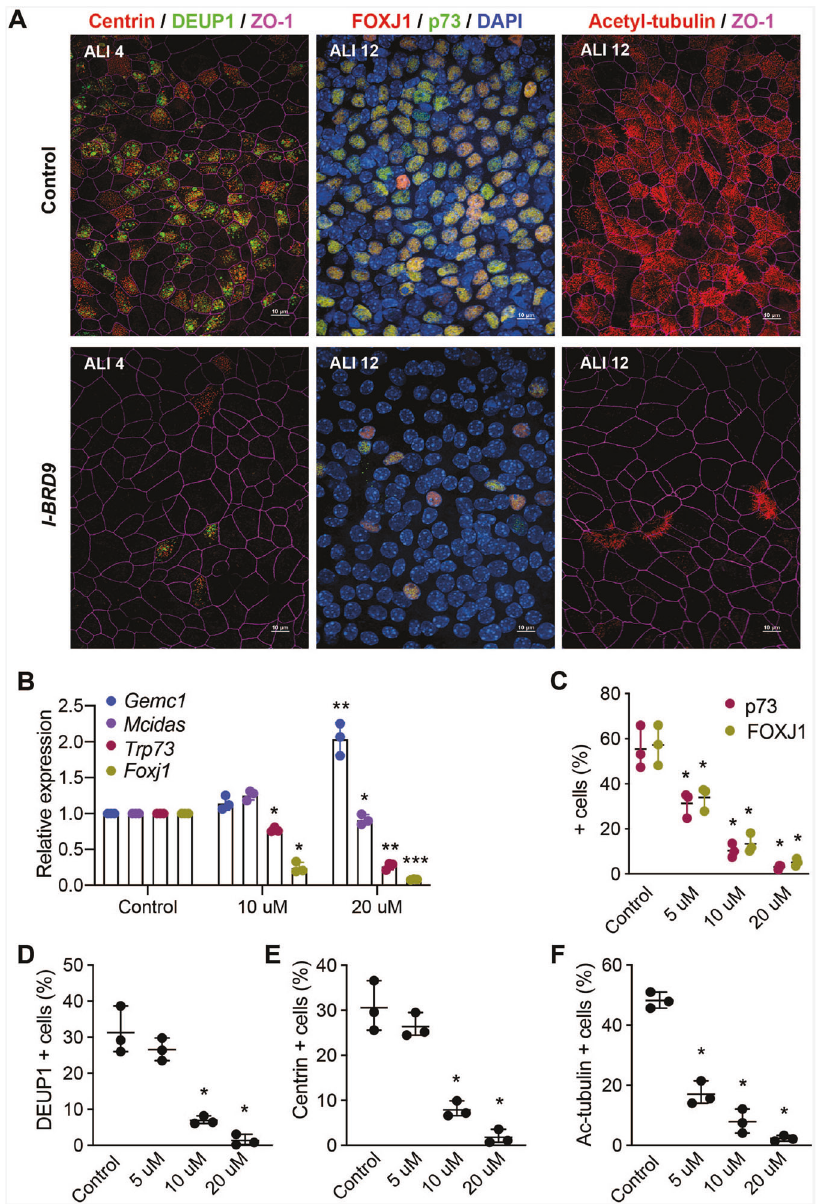
Fig. 6 BRD9 inhibitors impair multiciliation in MTECs. A Representative images of MTEC ALI cultures stained for Centrin and Deup1 to analyze centriole ampli fi cation, Foxj1 and p73 transcription factor targets of GEMC1/MCIDAS, or Acetylated tubulin (Ac-tubulin) to monitor ciliogenesis. Some images stained with ZO-1 to de fi ne cell boundaries or DAPI to de fi ne the nuclear DNA. ALI culture day and treatment with 20 μ M I-BRD9 indicated. B Quantitative real-time PCR analysis of Gemc1, Mcidas, Trp73 , and Foxj1 in ALI cultures. Results from three independent experiments are shown with bar indicating mean and standard deviation. Paired t -tests were used for statistical analysis: Control vs. I-BRD9: Foxj1 p = ≤ 0.013* (10 μ M) and 0.0003*** (20 μ M), Trp73 p = 0.009* (10 μ M), = ≤ 0.009** (20 μ M), Gemc1 p = 0.008** (20 μ M), and Mcidas p = 0.02* (20 μ M). C Fraction of cells committed to the MCC fate (p73 + or FoxJ1 + ) at ALI 12. Results are from 3 independent experiments. N (total cells) = control (2128), 5 μ M (1665), 10 μ M (1273), and 20 μ M (1360). D Fraction of cells undergoing centriole ampli fi cation (centrin-positive cells) or E deuterosome formation (Deup1-positive cells) at ALI 4. Results are from three independent experiments. N (total cells) = control (1269), 5 μ M (1062), 10 μ M (1199), 20 μ M (1170). F Fraction of ciliated cells at ALI 12. Results are from three independent experiments. N (total cells) = control (1814), 5 μ M (1295), 10 μ M (1113), 20 μ M (1099). Statistical analyses for C – F were done using one-way ANOVA. * p < MCIDAS, are key factors that organize the transcriptional multiciliation. In addition, the direct involvement of MCC regulation of MCC differentiation [18]. Yet, several lines of dysfunction in the etiology of a broad spectrum of human evidence point to distinct functions for GEMC1 and MCIDAS in pathologies like respiratory disorders, fertility issues and hydro- MCC differentiation that is not adequately explained by our cephalus, has led to a signi fi cant degree of interest in the biology current understanding of their molecular interactions. In this work, of this specialized ciliated cell-type. We and others have previously we compared their transcriptional targets and proximal established that the two Geminin family members, GEMC1 and